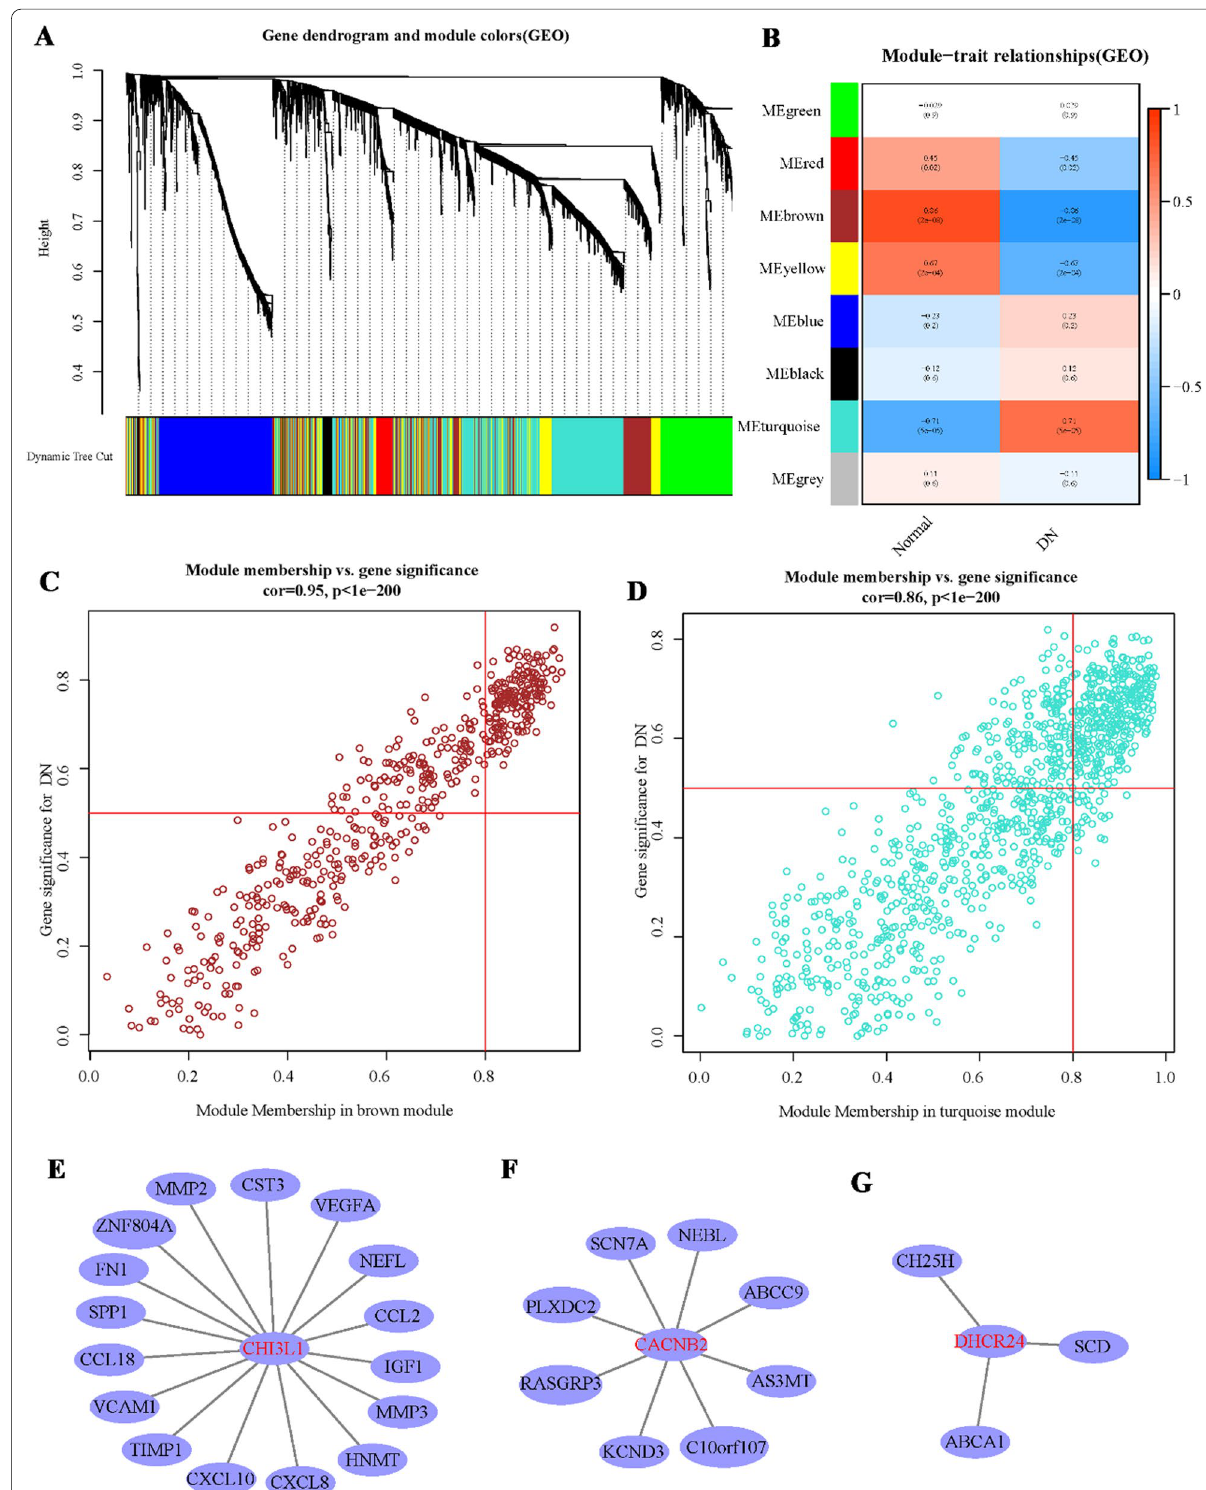
Fig. 3 A–D WGCNA algorithm sifted out DHCR24, CHI3L1, and CACNB2, which have mutual relations; E–G the interaction network of DHCR24, CHI3L1, and CACNB2 with modular genes. * P < 0.05; ** P < 0.01; *** P <